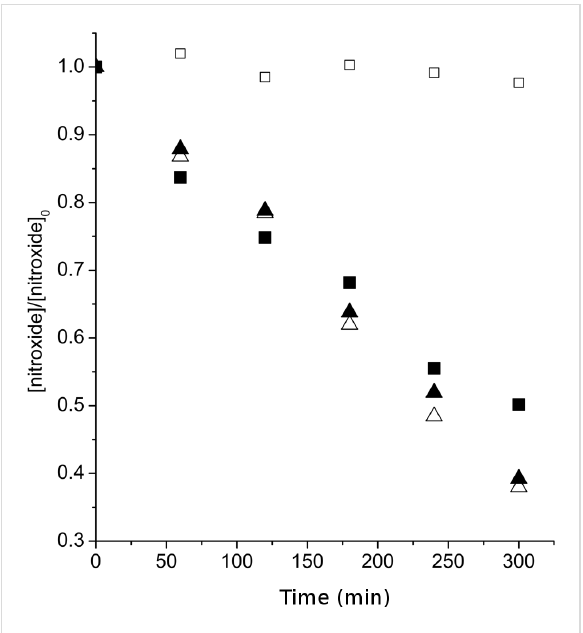
Figure 4: Degradation of the SG1 (triangles) and TEMPO (squares) nitroxides versus time in the presence of 0 (empty symbols) and 10 (filled symbols) mol equivalents of D-glucose as measured by ESR in t -BuPh at 25 °C (samples heated in DMA at 120 °C and then diluted in t -BuPh).